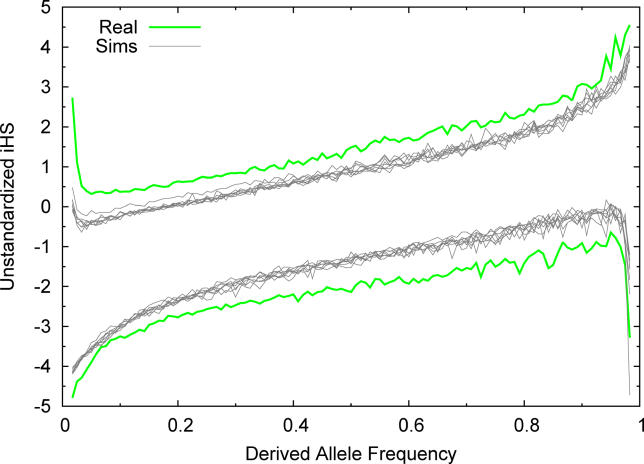
Central 99% Range of Unstandardized iHS for SNPs in the Yoruba Data and for SNPs in Matched Neutral SimulationsThe upper and lower lines mark the boundaries of the central 99% distribution of the unstandardized iHS ratio, as a function of derived allele frequency. The gray lines plot results for a range of plausible demographic models. The fatter tails in the real data are consistent with the action of selection.